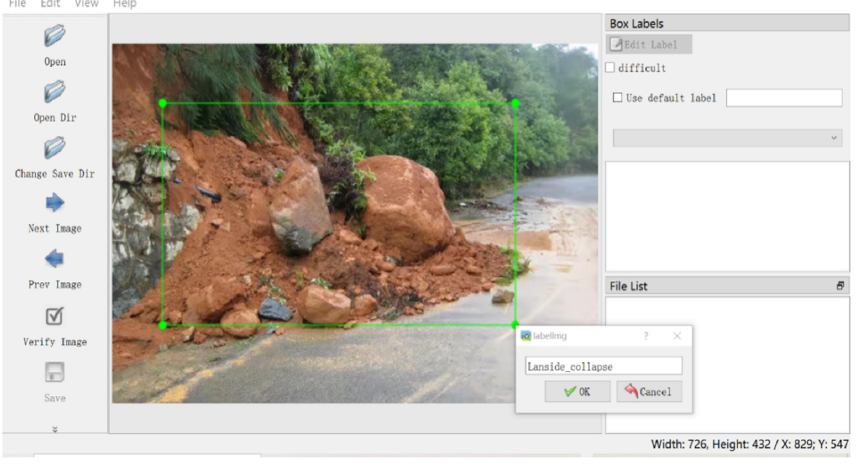
Figure 8. LabelImg operation interface.